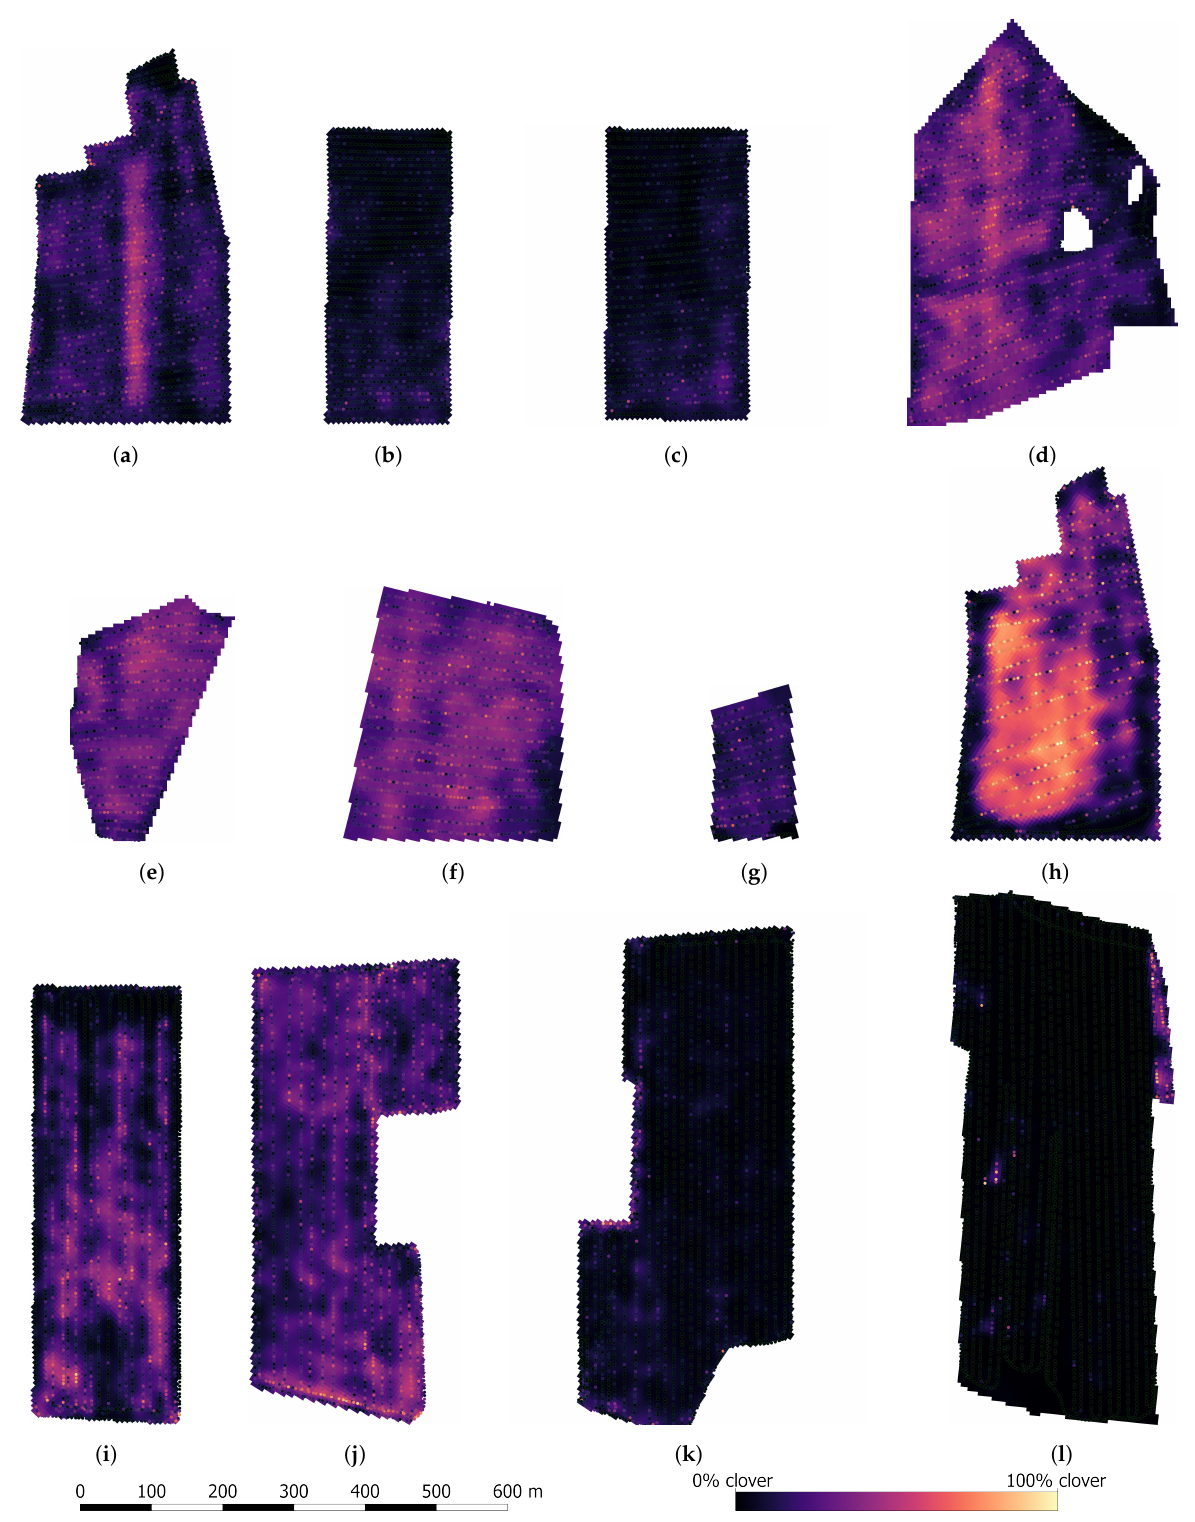
Figure 13. Visualization of the visual clover fraction in a subset of the large scale mapped fields. Fields ( a – g ) were sampled in May. Fields ( h – l ) were sampled in October. Each square unit represents a 5 represents the visually predicted clover fraction in a corresponding